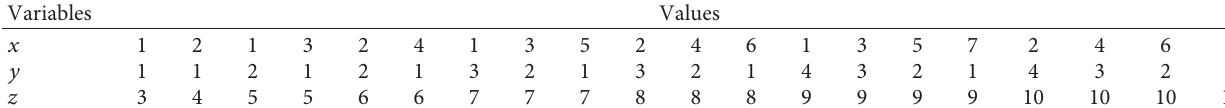
Table 1: All solutions to x + 2 y � z in the interval [ 1 , 10 ] .